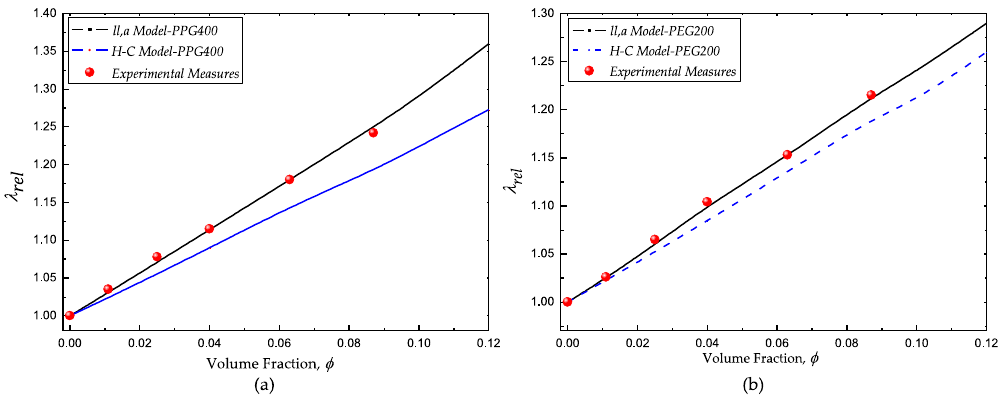
Figure 5. Comparative results of the experimental measurements with the Hamilton–Crosser (HC) model and the liquid-layering-agglomerate model. ( a ) fumed silica in PPG400 and ( b ) fumed silica in PEG200.